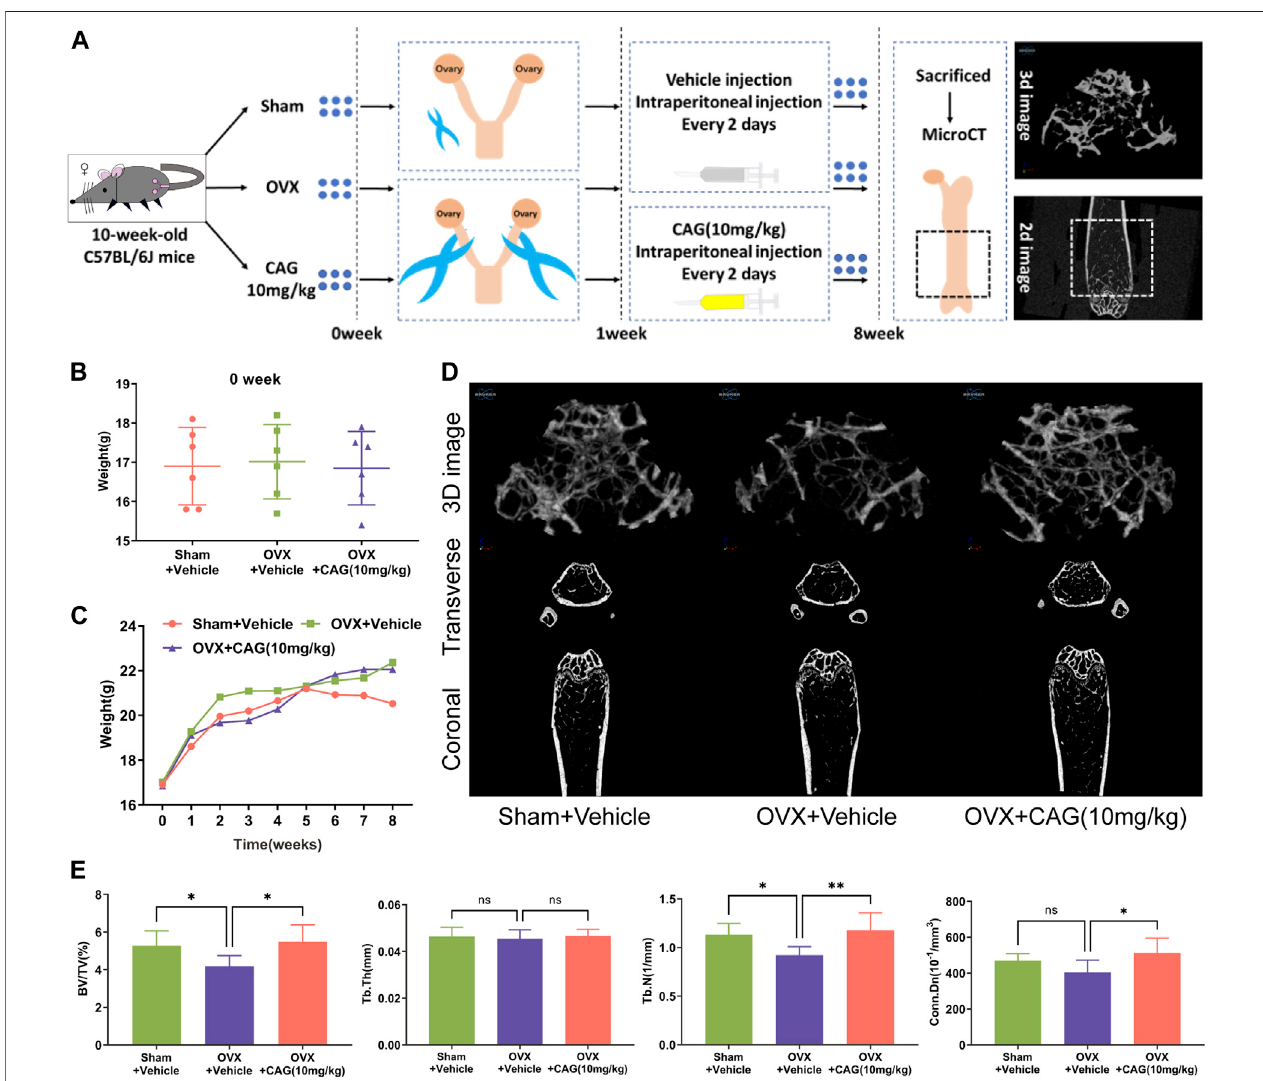
FIGURE 5 | CAG alleviates MPO-related bone loss in mice. (A) Flow chart of PMO model induced by OVX in female C57BL/6J mice. (B) The initial body weight of micehadaconsistentbaselineindifferentgroups. (C) Weeklybodyweightchangesofmiceindifferentgroupswererecorded. (D) Typical2Dand3Dimagesofthedistal femur of MPO mice were reconstructed by MicroCT scanning after 7 weeks of exposure to CAG (10 mg/kg). (E) Quantitative analysis exhibited that CAG management markableimprovedtheboneparametersoffemoralROIinMPOmice,includingBV/TV,Tb.N,andConn.Dn.Dataofallhistogramsaredisplayedasmean(SD).n